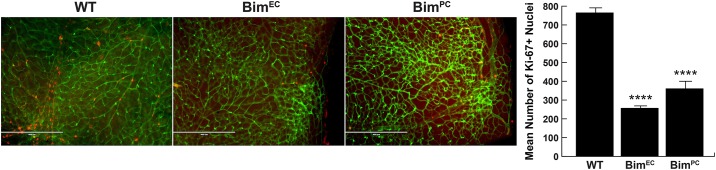
Decreased proliferation in retinas from conditional Bim mice.Proliferating cells in P14 wild-type, BimEC and BimPC mouse retinas were assessed by anti-Ki-67 staining (red) and co-stained with Isolectin-B4-FITC (green) to visualize the vasculature. The data in each bar are the mean number of Ki-67 positive cells counted in each retina. Please note that the number of proliferating cells is lower in retinas from conditional Bim mice compared to their wild-type counterparts (n = 6, ****P< 0.0001). Scale bar equals 400 μm.